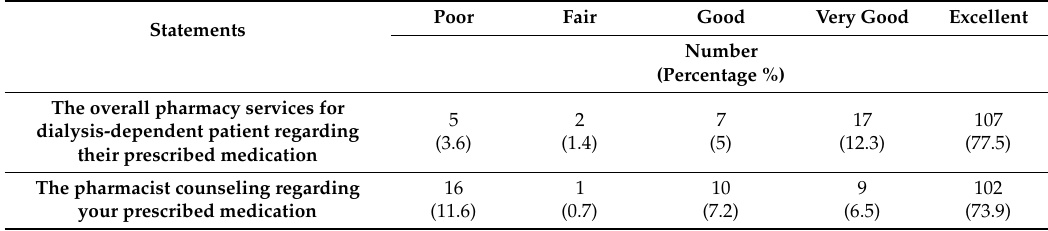
Table 5. Overall patient satisfaction.